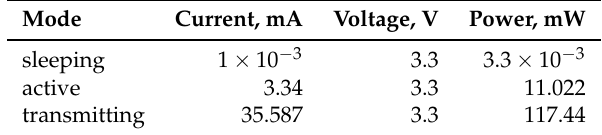
Table 3. Sensor node power consumption in different modes. The node lifetime increases with capacitor